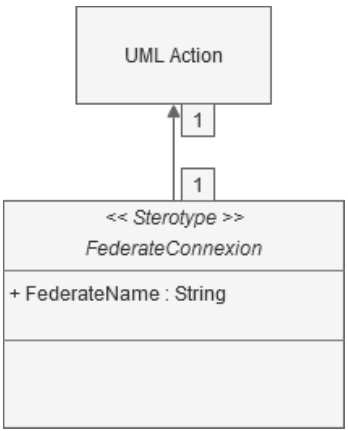
Figure 7. High-level architecture (HLA) Papyrus profile.